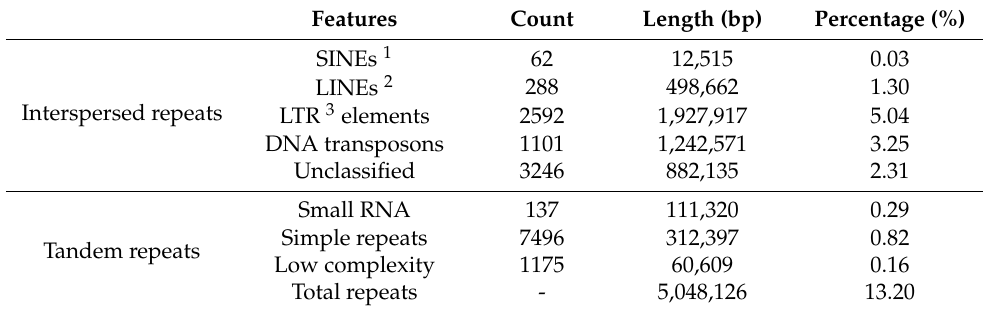
Table 2. Repeats Identified in Stagonospora Tainanensis Strain